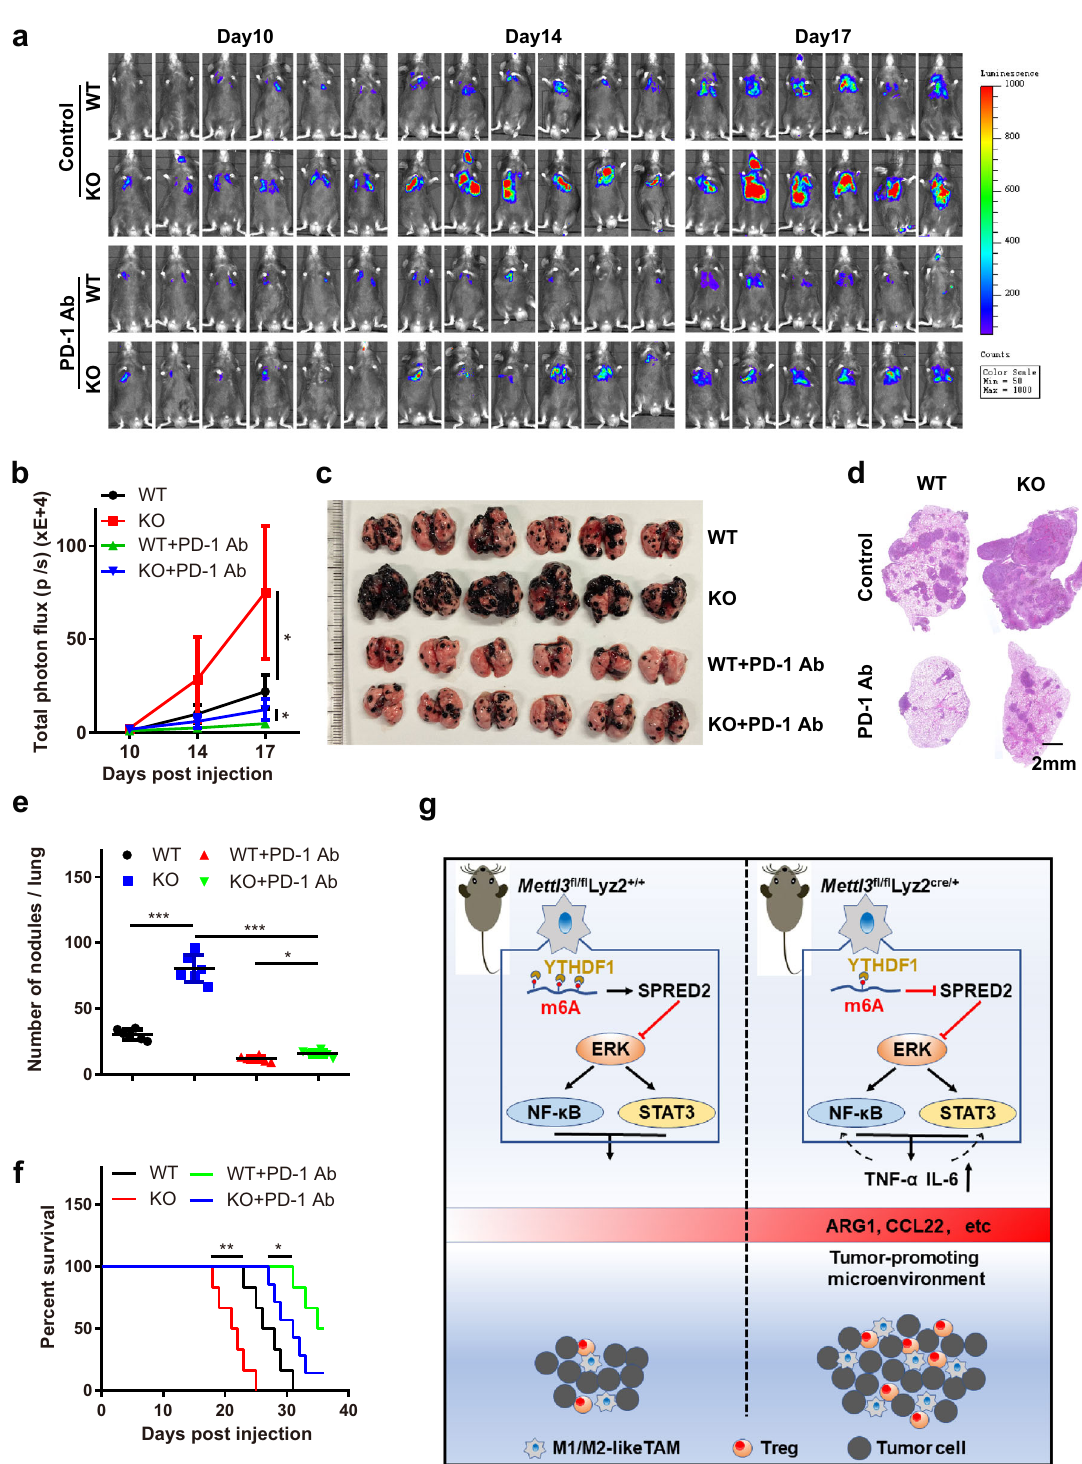
Fig. 7 Mettl3 depletion in macrophages impairs PD-1 blockade therapeutic ef fi cacy in B16 tumours. a – f B16 cells were intravenously injected into WT and KO mice. An anti-PD-1 Ab was injected on days 0, 3, 6, 9, 12. Bioluminescence was measured at the indicated time points, and representative images are shown ( a ) and were quanti fi ed ( b ) ( n = 6 mice per group). Lungs were dissected and photographed ( c ), and representative HE staining images of lung sections are shown ( d ). Lung metastatic nodules ( e ) ( n = 6 mice per group) and overall survival ( f ) were observed (WT, KO or WT + PD-1 Ab group, n = 6 mice; KO + PD-1 Ab group, n = 7 mice). g Schematic showing that Mettl3 ablation in myeloid cells impairs the translation of SPRED2 mediated by YTHDF1, which facilitates tumour progression by regulating cytokine responses and enhancing tumour-promoting macrophage and Treg in fi ltration. Data are shown as the mean ± SD. P values were determined by a two-tailed t -test ( b , e ) and the Gehan – Breslow – Wilcoxon test ( f ). * P ≤ 0.05, ** P < 0.01 and *** P < 0.001. The source data are provided as a Source data fi